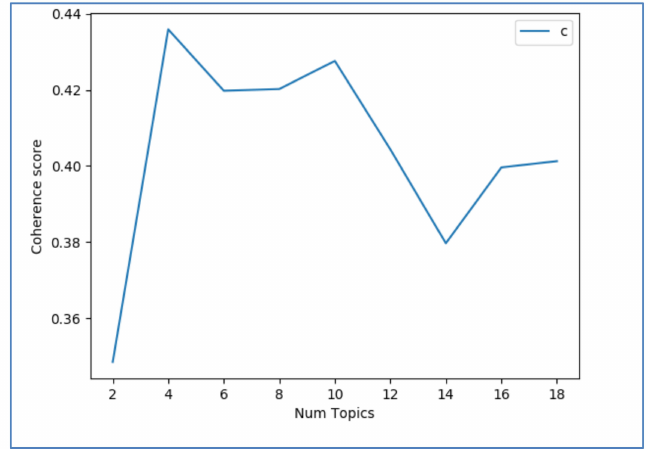
Figure 13. The optimal number of topics (fear tweets).